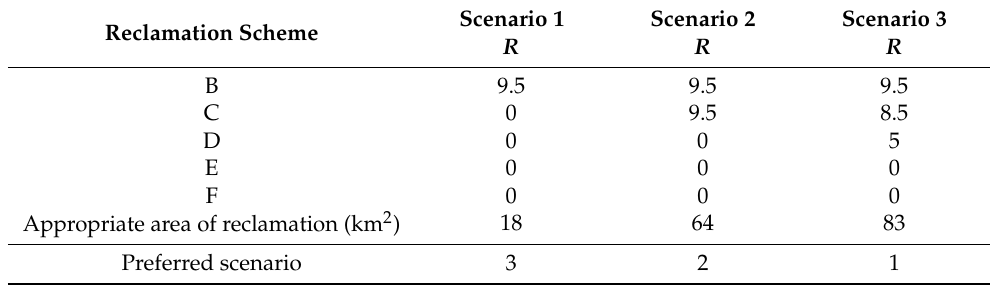
Table 25. Comprehensive evaluation of the three scenarios for CR. Reclamation